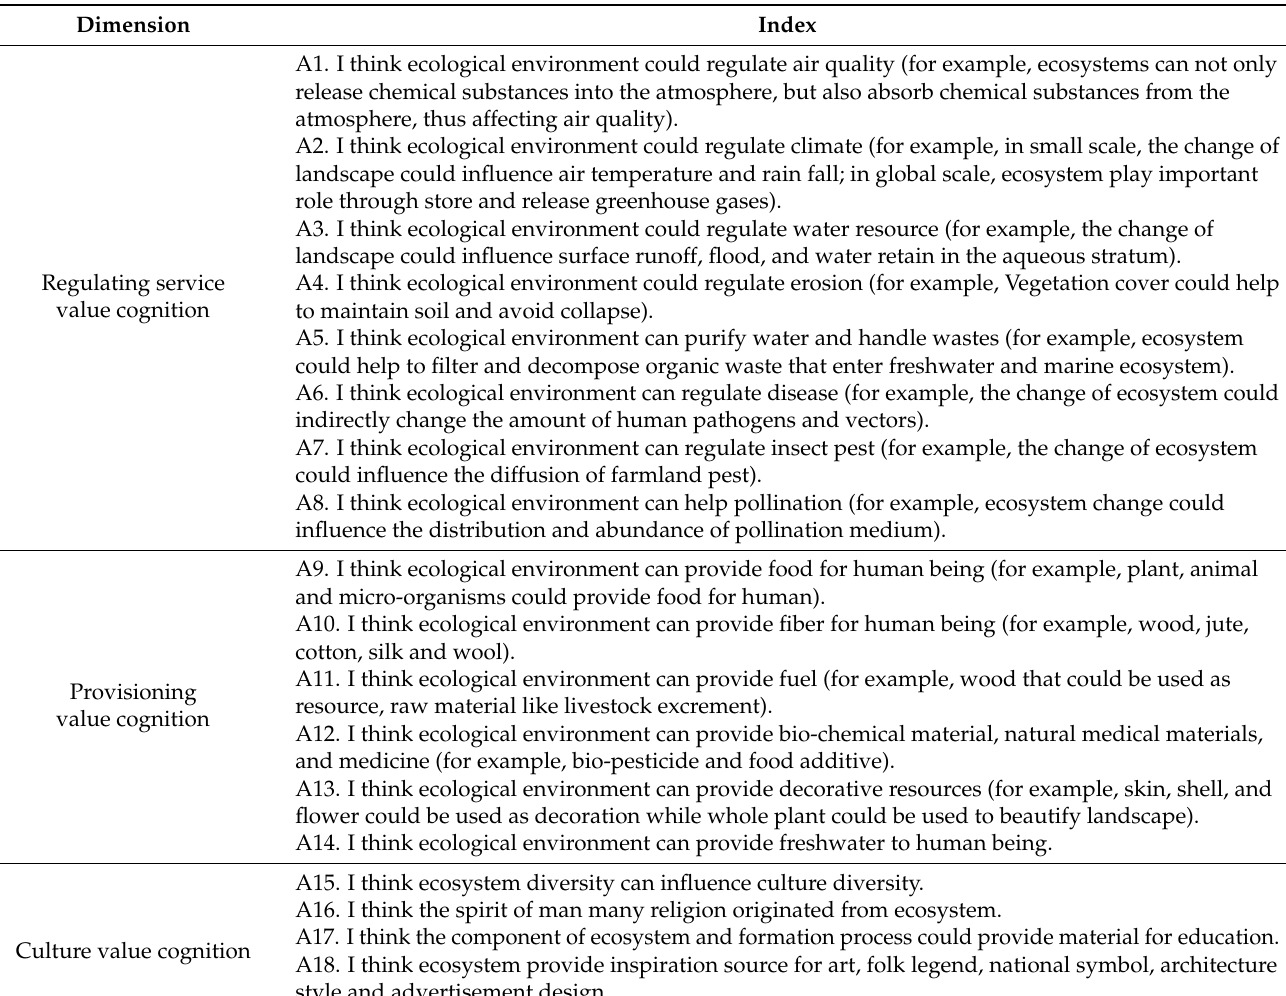
Table 2. Scale table of ecological value